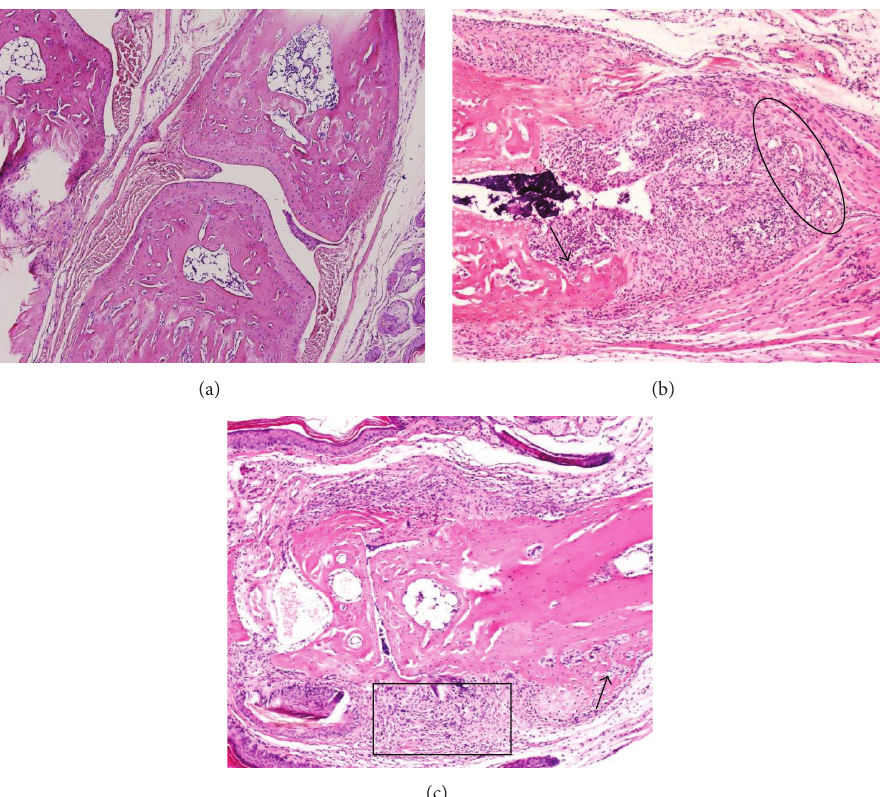
Figure 3: Histopathological evaluation. (a) The Normal mice showed normal joint space at the interphalangeal joint, 1–3 synovial cell layers, and smooth articular cartilage surface. (b), (c) CIA mice showed diminished interphalangeal joint space and diffuse infiltration of inflammatory cells (square area); significant proliferation of synovial cells and synovial cells invasion into cartilage and bone (arrow); visible neovascularization at synovial hyperplasia areas and inflammatory cell infiltration at perivascular areas (ring area). Magnification ( ×